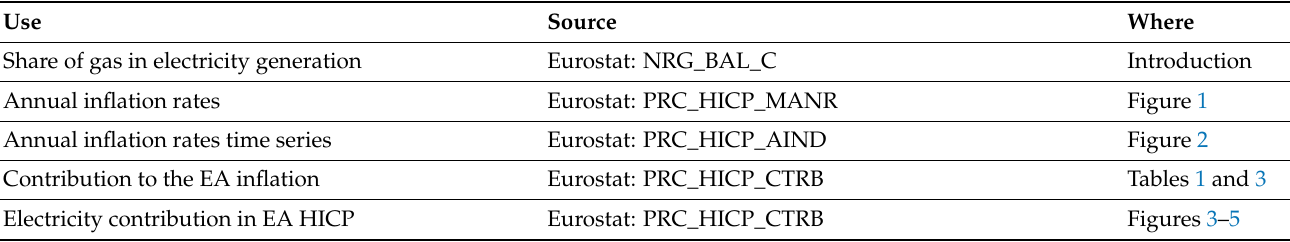
Table A1. Data retrieved from Eurostat, FED, and